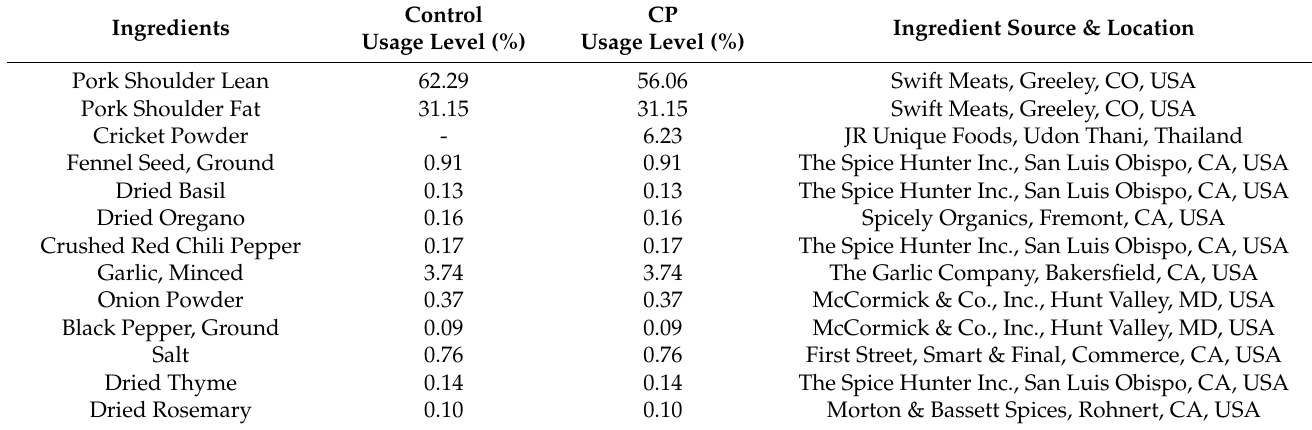
Table 1. The usage levels of the ingredients used for the sausage blend with NO cricket powder (Control) and sausage blend containing cricket powder (CP). All percentages were rounded to the nearest hundredth